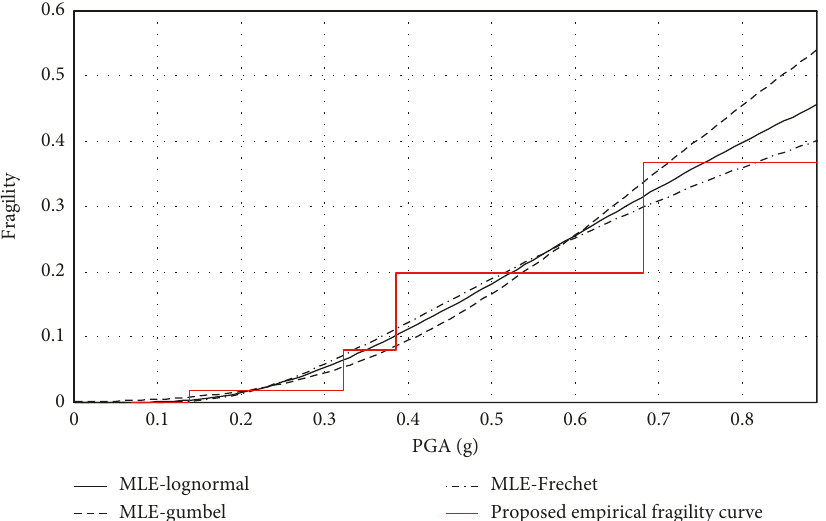
Figure 8: Comparison of empirical fragility curves of damage state with Moderate.